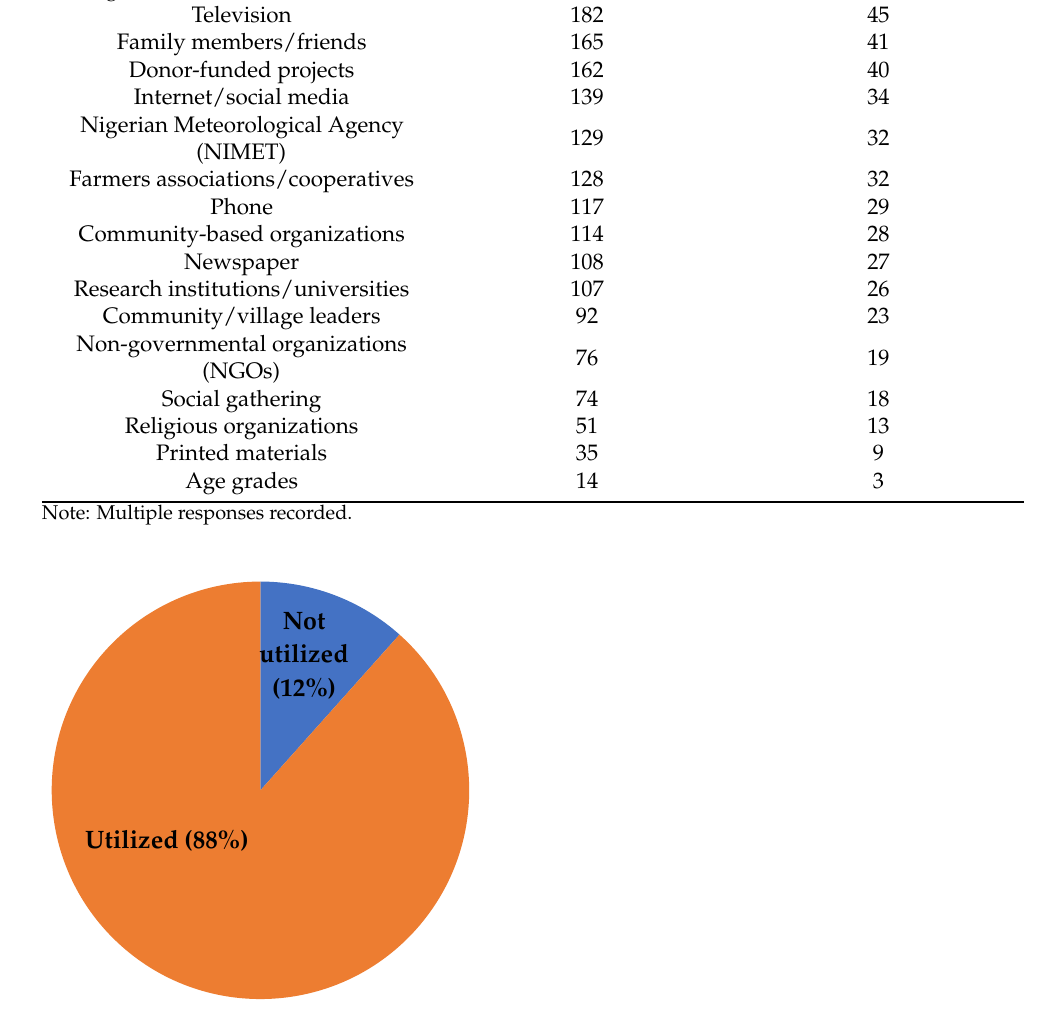
Figure 3. Percentage distribution of farmers according to use of climate information services.